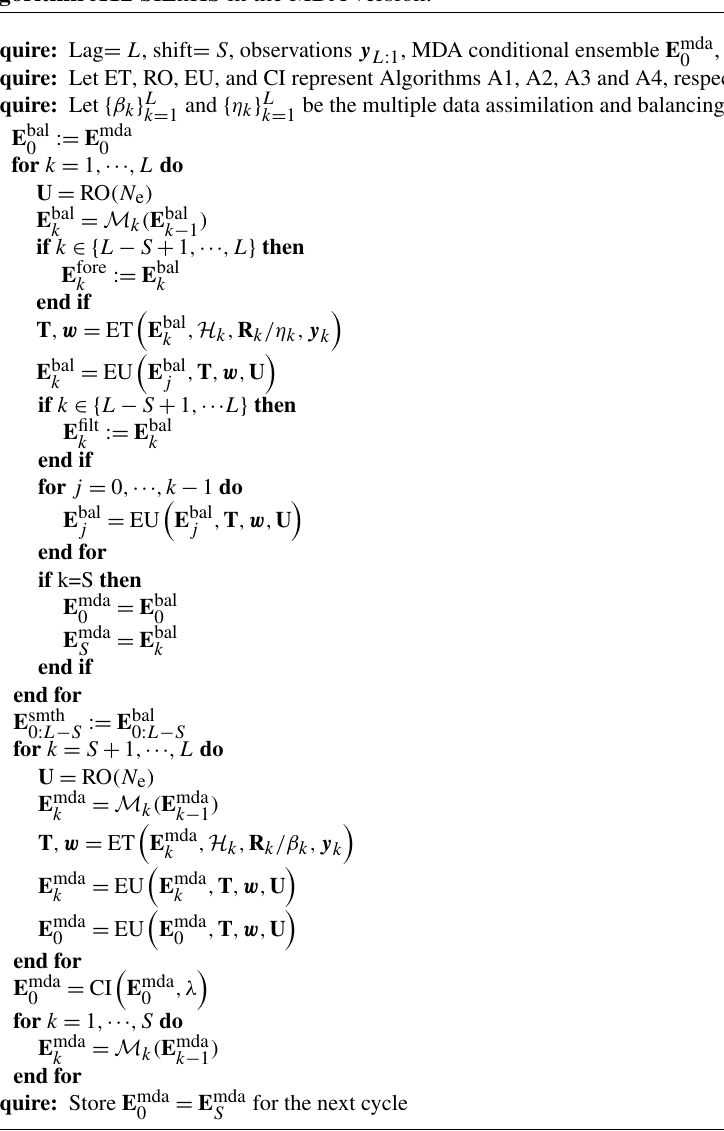
Algorithm A12 SIEnKS in the MDA